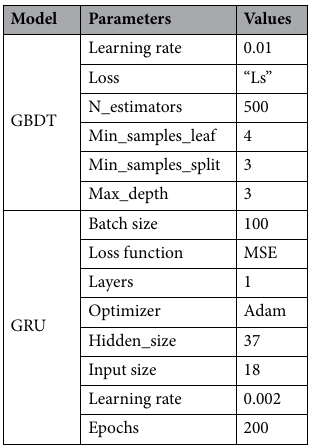
Table 2. Parameters settings of GBDT and GRU